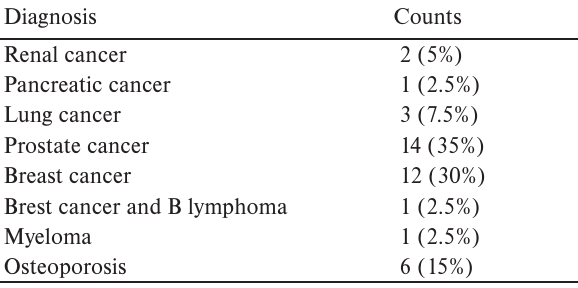
Table 1. List of primary diagnoses.